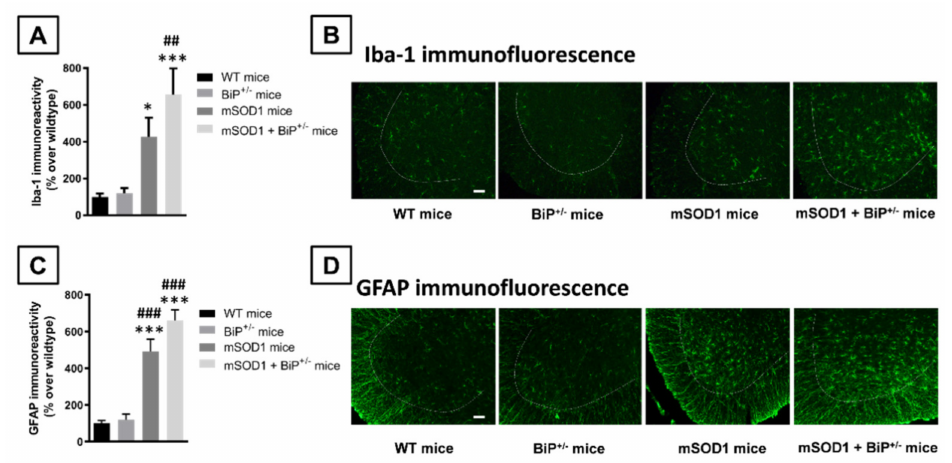
Figure 3. Quantification of Iba-1 (panel ( A )) and GFAP (panel ( C )) immunoreactivity, including representative images (panel ( B ) and ( D ), respectively; scale bar = 100 µ m), in the lumbar ventral horn (marked with a dotted line) of the spinal cord in mSOD1 transgenic and wild-type male mice with normal or partial ablation of the BiP protein. Values are means ± SEM of 5–7 animals per group. Data were assessed by one-way analysis of variance followed by the Tukey test (* p < 0.05,